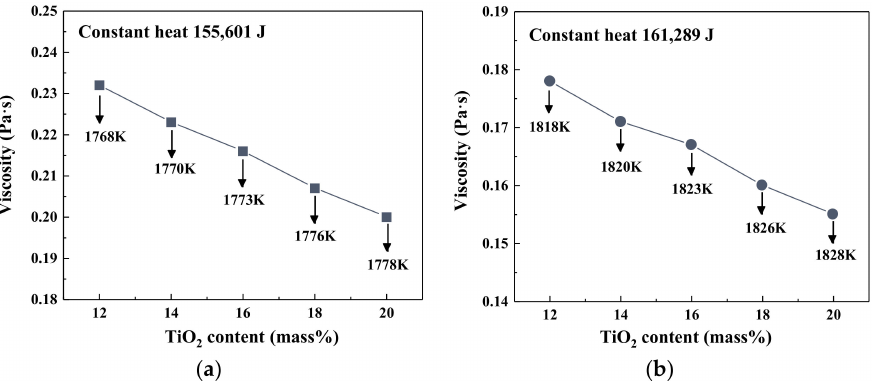
Figure 5. The viscosity of slag with varying TiO 2 content under constant heat quantity: ( a ) 155,601 J; ( b ) 161,289 J.